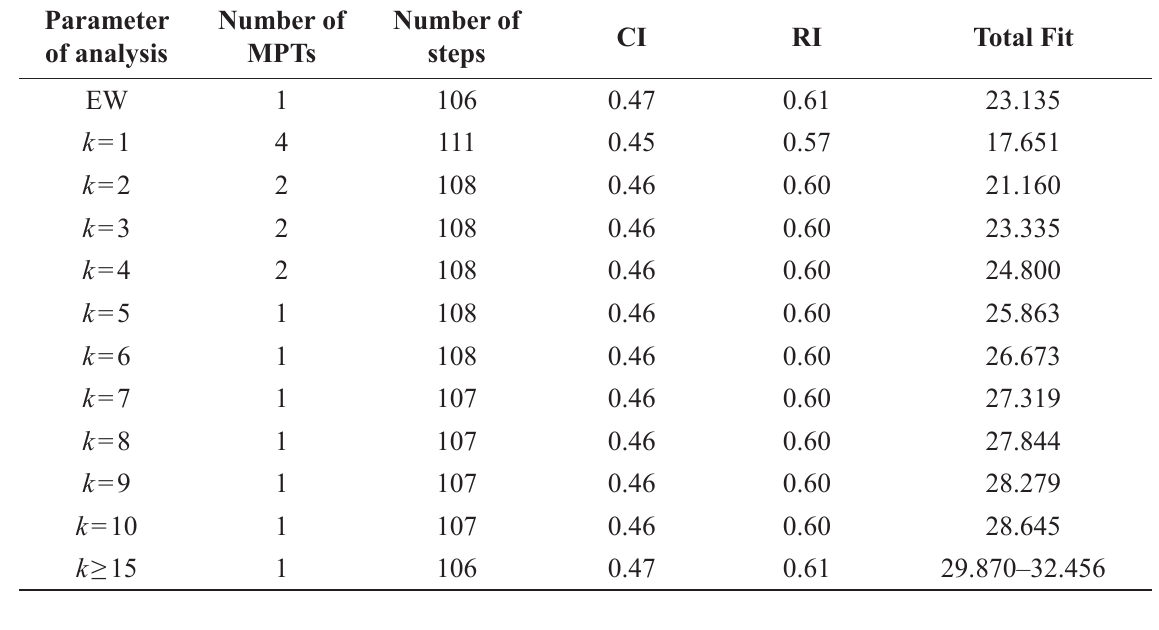
Table 1. Statistics obtained in the maximum parsimony phylogenetic analysis of different parameters. Abbreviations: EW = equal weights; k = concavity constant; MPT = most parsimonious tree; CI = consistency index; RI = retention index.